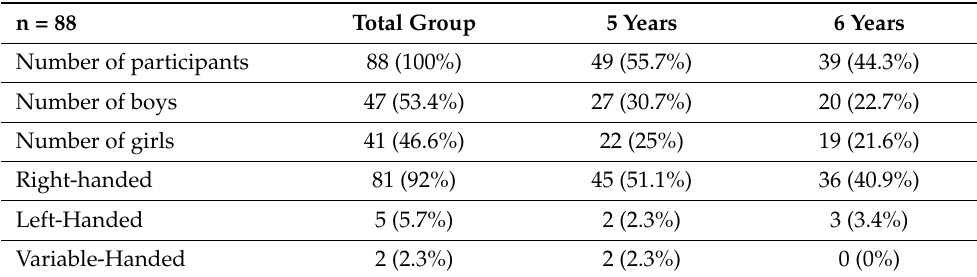
Table 1. Descriptive data of